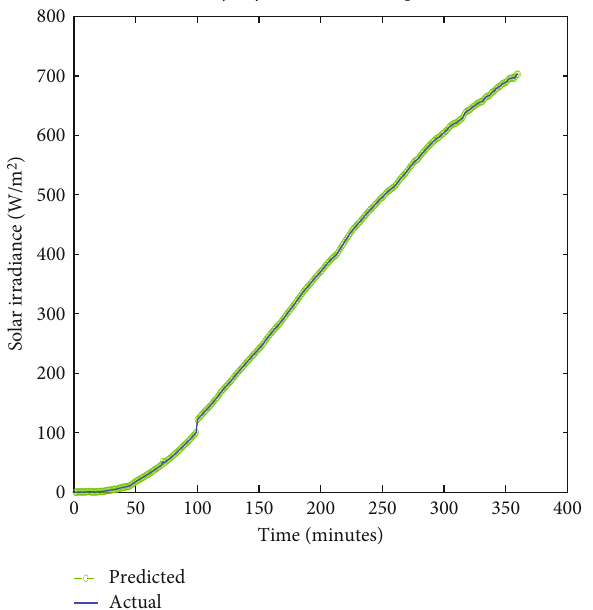
Figure 19: Comparison of predicted solar irradiance and actual solar irradiance for sunny day six-hour-ahead prediction.